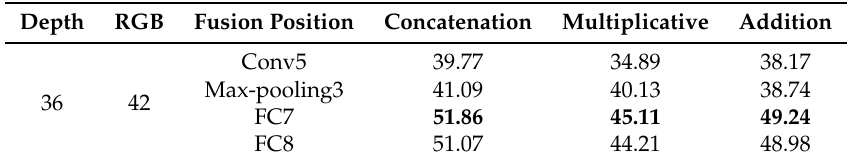
Table 12. Performance of AlexNet network and a KNN classifier based on spatial information (RGB and depth) in terms of MSR daily activity 3D dataset before and after fusion.